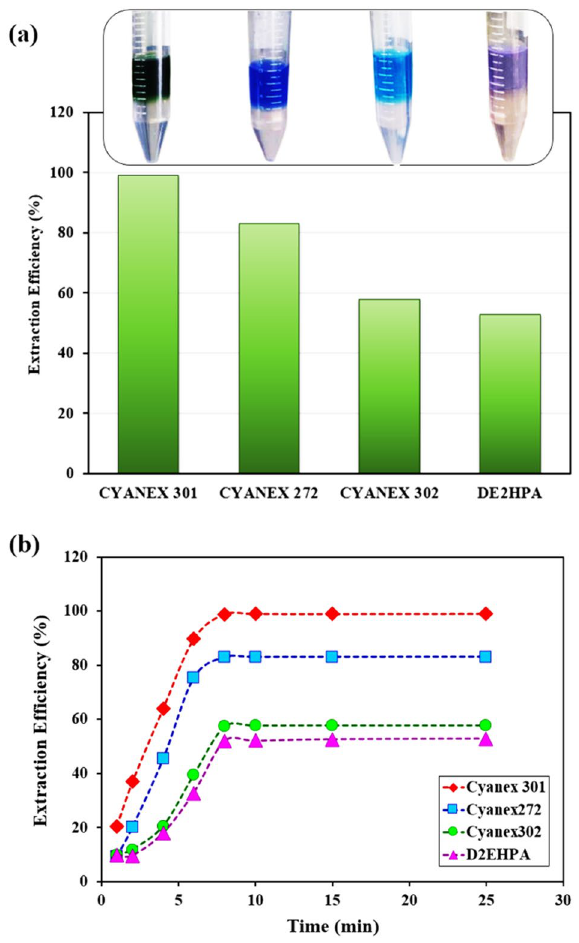
Figure 2. ( a ) Effect of extractant type on the extraction efficiency in non-aqueous solvent extraction system for Co(II) removal; ( b ) Effect of time on the extraction efficiency [(Co(II)) = 700 ppm; 80%EG + 20%Water; pH = 3; [LiCl] = 1 M; 0.05 M concentration for all